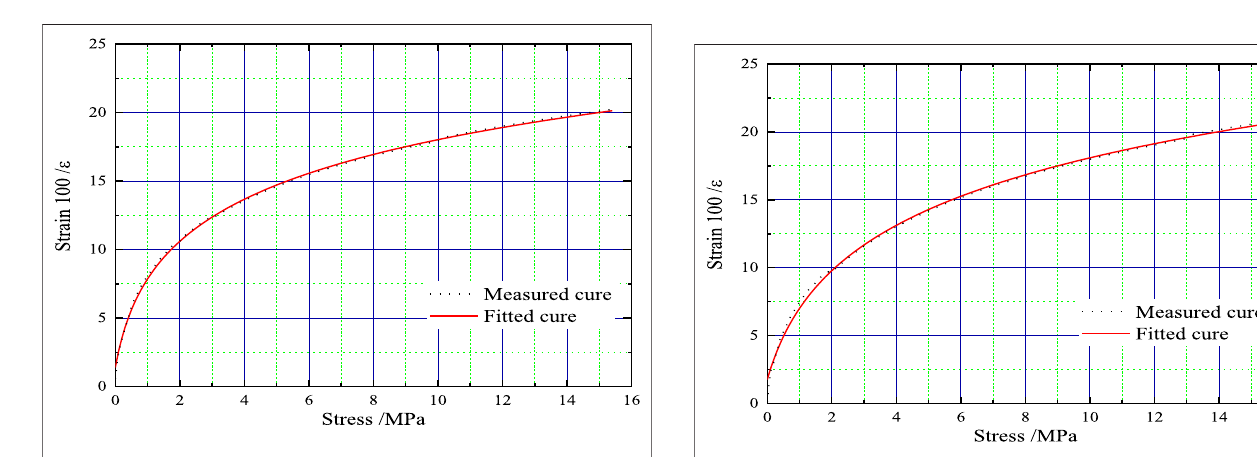
FIGURE 6 | Measured and fi tted stress – strain curves ( n (cid:1) 0.3).